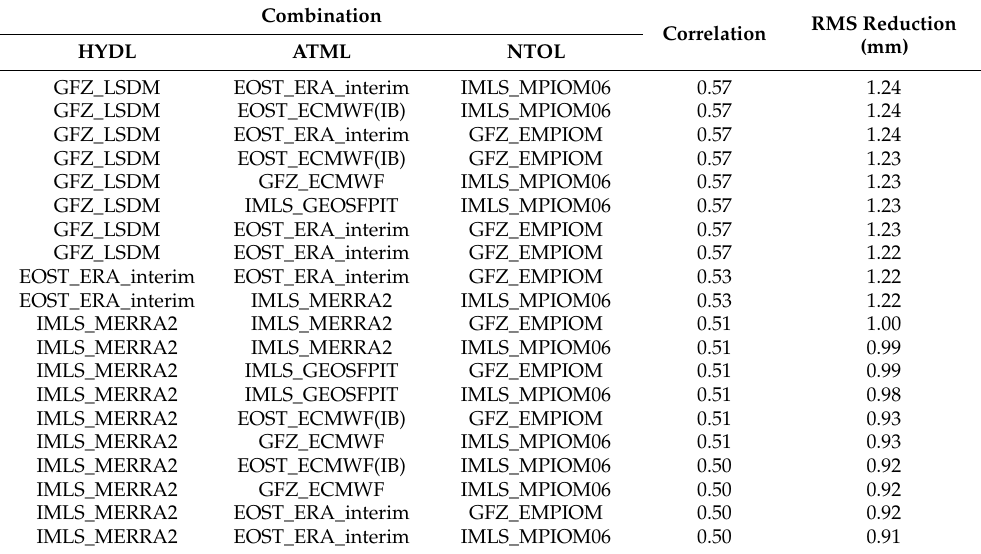
Table 2. The mean correlation and RMS reduction between the vertical GPS time series with the combination of environmental loading